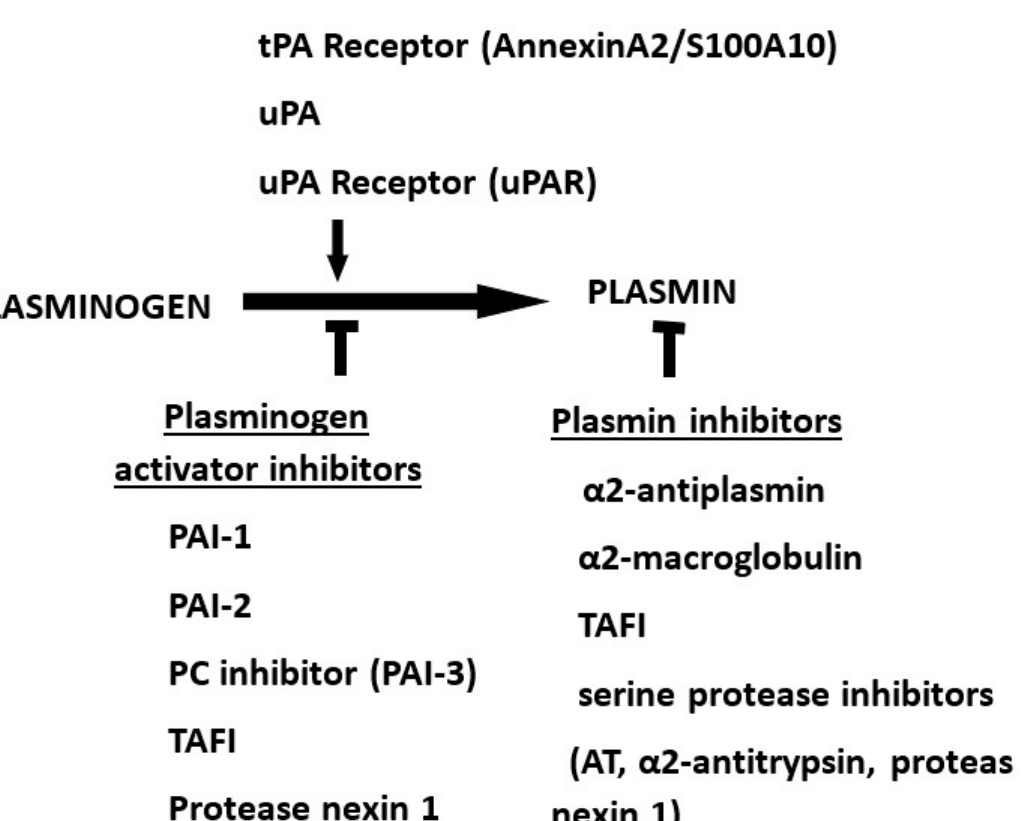
Figure 1. The fibrinolytic (plasminogen–plasmin) system. Table 2. Role of the fibrinolytic system in multiple